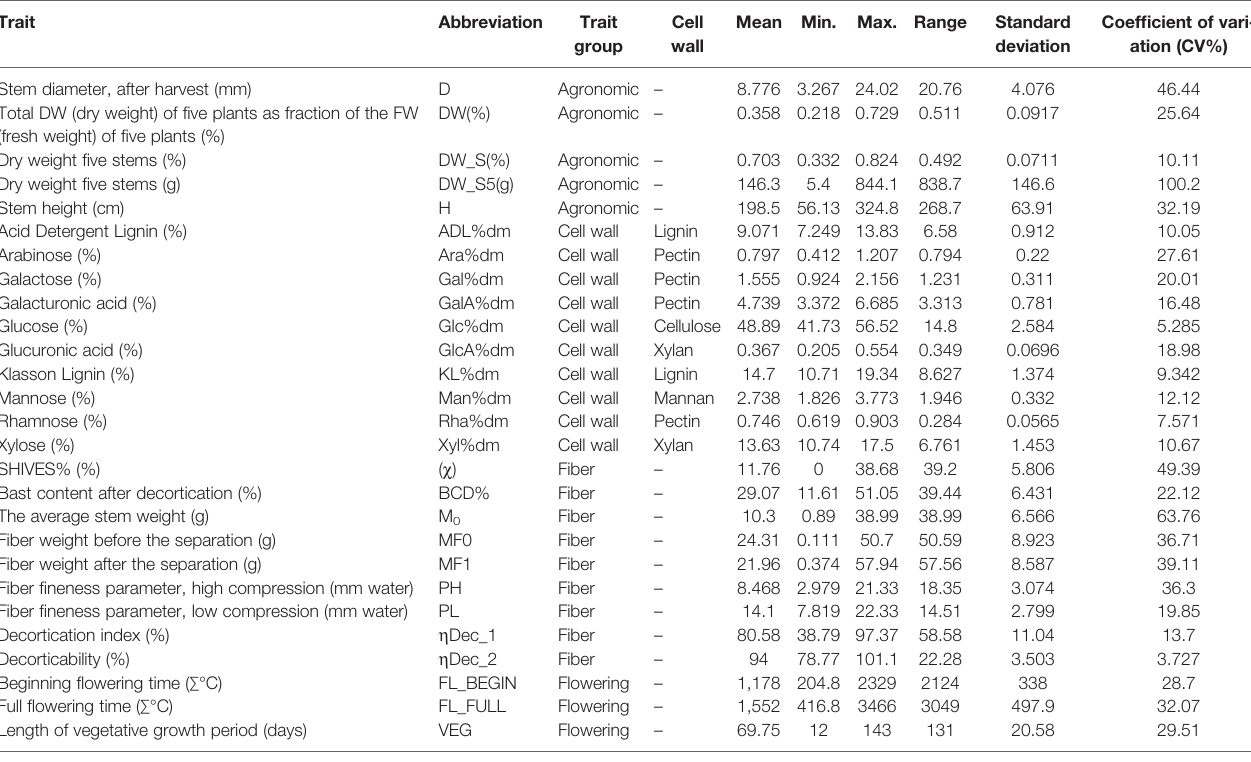
TABLE 3 | Summary statistics of 27 traits in 123 hemp accessions.